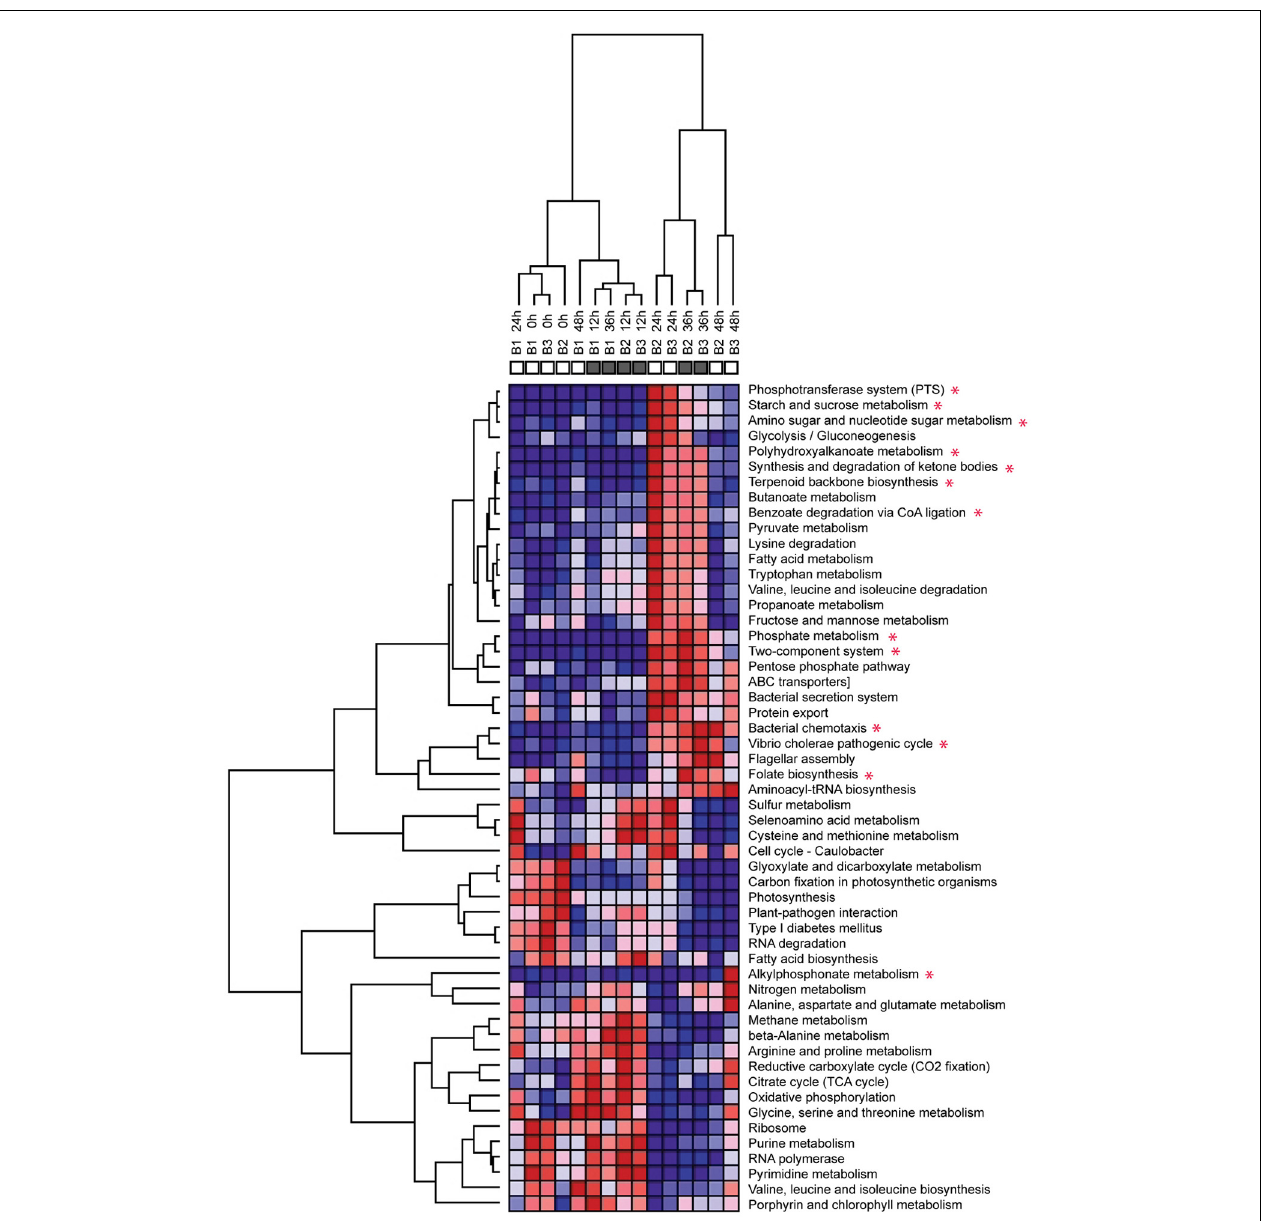
FIGURE 5 | Clustering of metatranscriptomics databases according to their KEGG pathway profiles. Heatmap shows relative distribution of protein-coding reads matching KEGG pathways. Red = high abundance, blue = low abundance. Color scale is row (pathway) normalized. Only pathways representing more than 1% mapped reads in at least one dataset